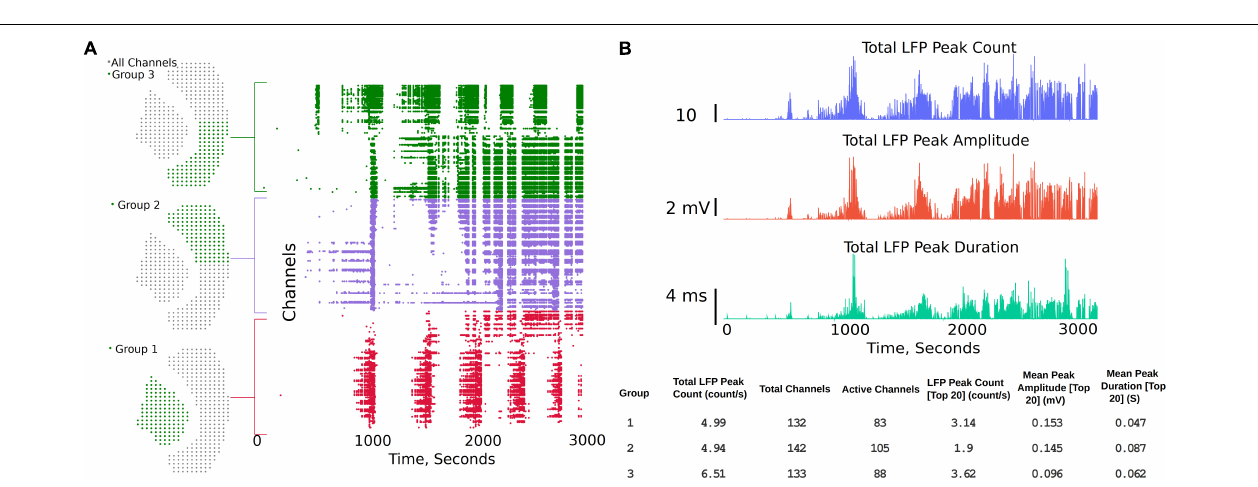
peak duration are shown in the summary plot and includes all the channels in the group. The plots and summary measures (SM) can easily be regenerated for suitable selection of the time